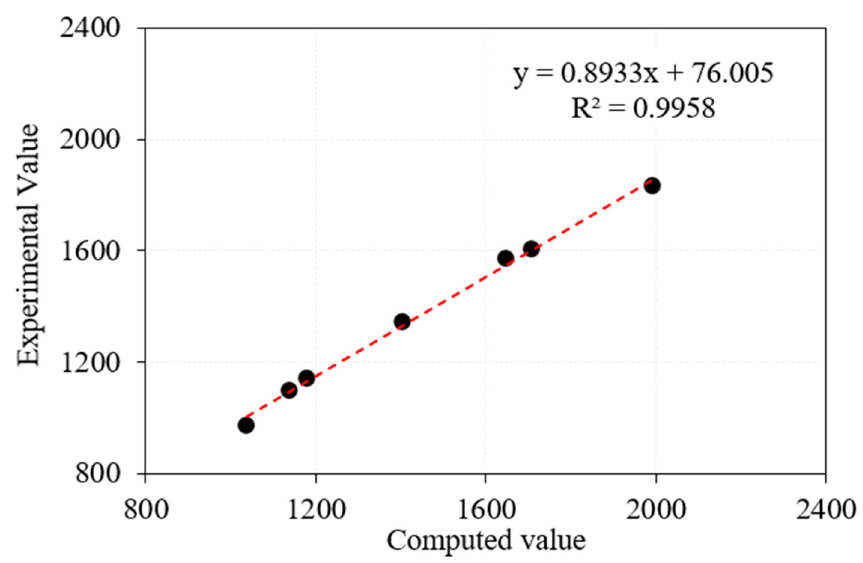
Figure 11. Comparison of impact failure energy (predicted versus experimental).